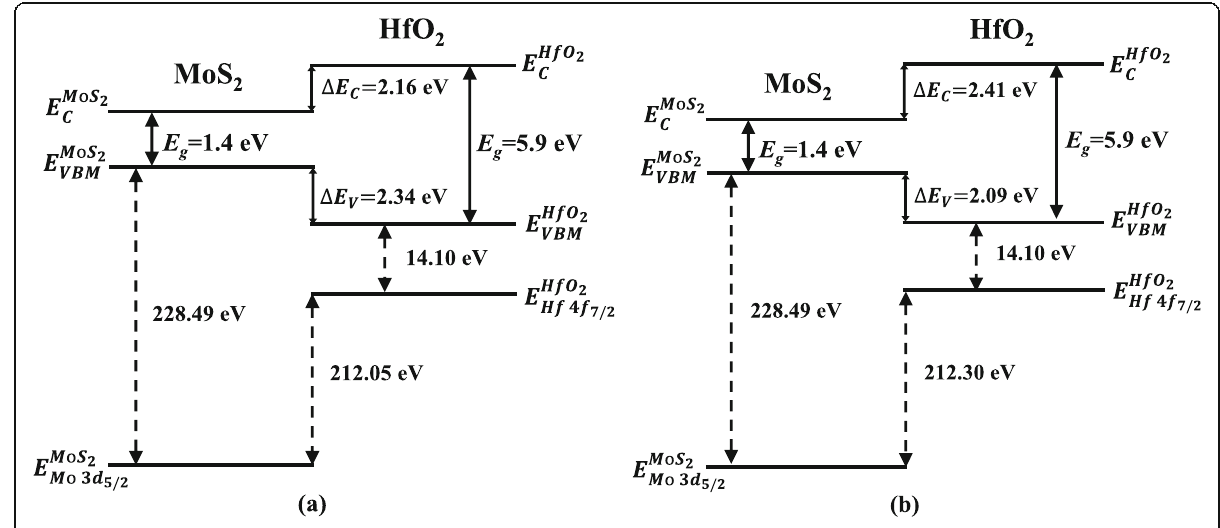
Fig. 4 Band diagrams of MoS 2 /HfO 2 heterojunction a without nitridation treatment and b with nitridation